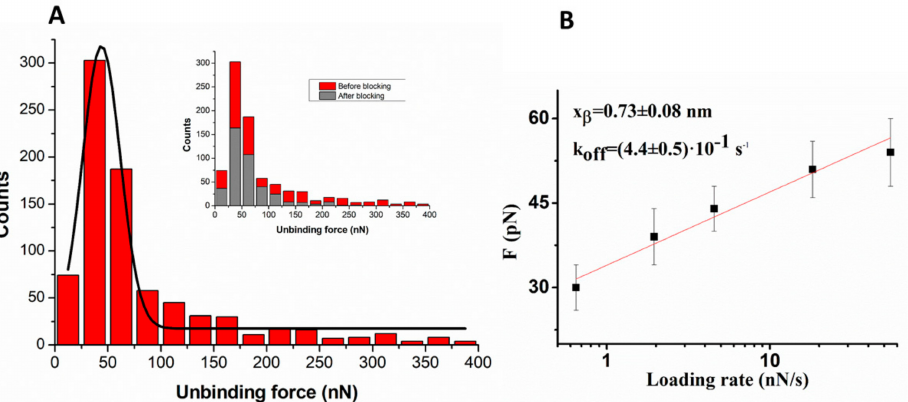
Figure 1. ( A ) Histogram of the unbinding forces for the HSA/miR-155 complex from AFS measure- ments carried out at a loading rate of 4.6 nN/s. The most probable unbinding force value (F*) has been determined from the maximum of the main peak of the histogram by fitting with a Gaussian function (black curve). Inset: Histogram of the unbinding forces for the HSA/miR-155 complex before and after blocking, at the same loading rate. ( B ) Plot of the most probable unbinding force, F*, vs. the logarithm of the loading rate for the HSA/miR-155 complex. The red continuous line is the best fit by the Bell–Evans model with Equation (1); the extracted values for the k off and x β parameters are